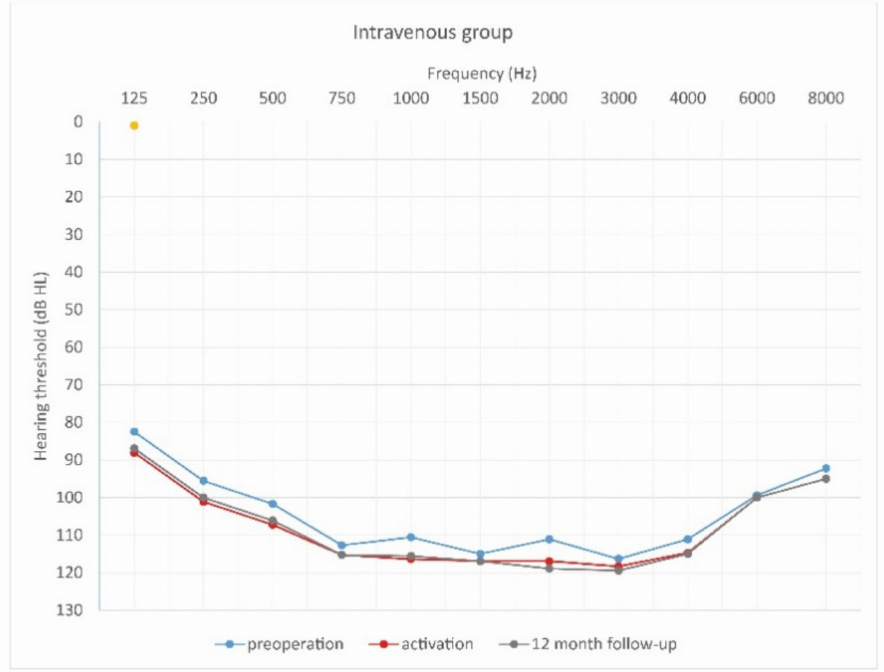
Figure 7. Mean hearing thresholds of patients with standard steroid therapy (i.v. group) in the pre-operative period, upon activation, and in the twelve-month follow-up after CI